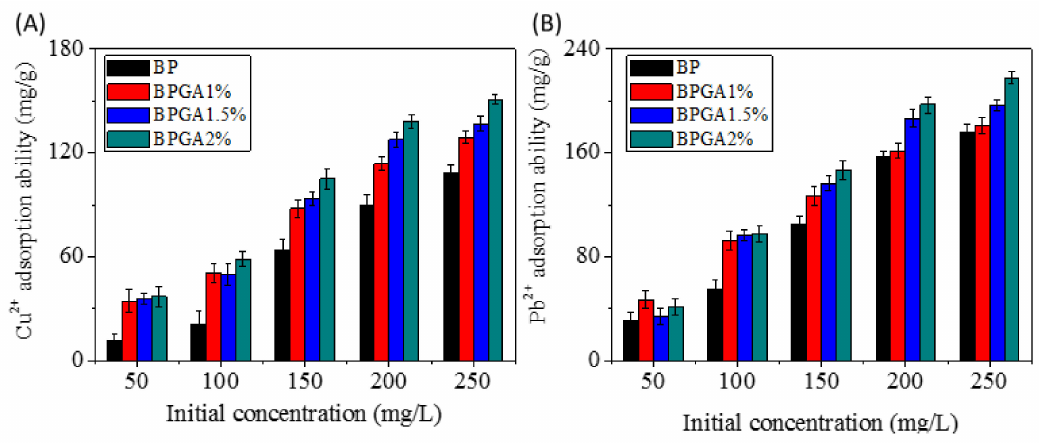
Figure 9. E ff ect of the initial metal ion concentration on the adsorption performance. ( A ) Cu 2 + , ( B ) Pb 2 +